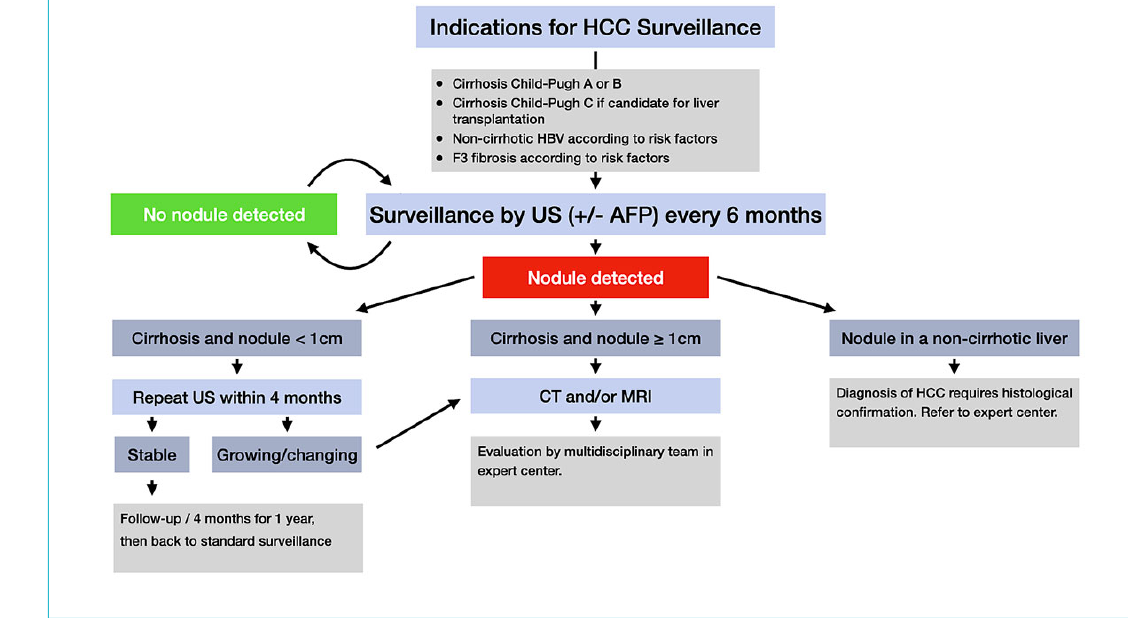
Figure 1: Overview of indications for HCC surveillance and recall policy in case of identification of a liver nodule.AFP = alpha-fetoprotein; CT = computed tomography; HBV = hepatitis B virus; MRI = magnetic resonance imaging; US =